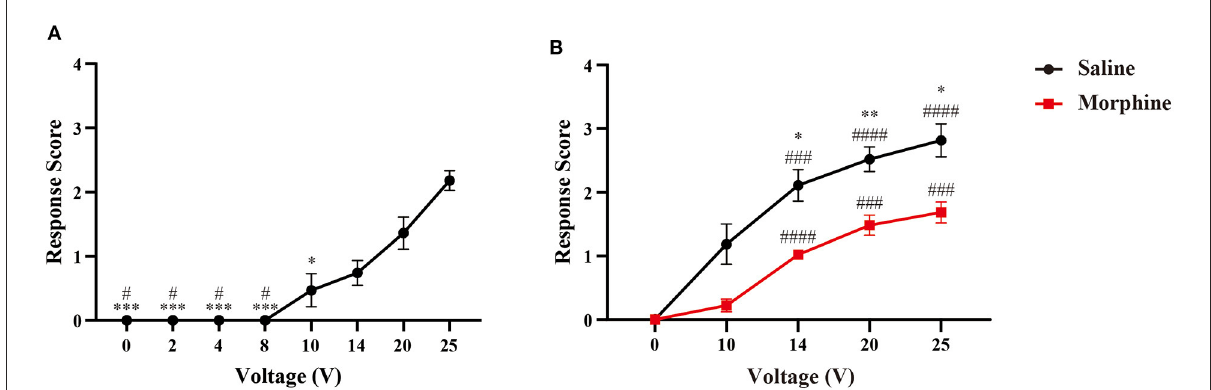
FIGURE3 Responsive scoring testing in naïve rats. (A) Dose-response relationship between response scores and stimuli intensity. Data is presented as mean ± standard error of the mean (SEM). N = 10; * p < 0.05, *** p < 0.001, compared with 25V; # p < 0.05, compared with 20V. One-way ANOVA with repeated measures and post-hoc Bonferroni test. (B) Analgesic effect of morphine on response scores. N = 9; * p < 0.05, ** p < 0.01, morphine vs. saline; ### p < 0.001, #### p < 0.0001, intra-group analysis compared with 0V. Two-way ANOVA with repeated measures and Bonferroni’s